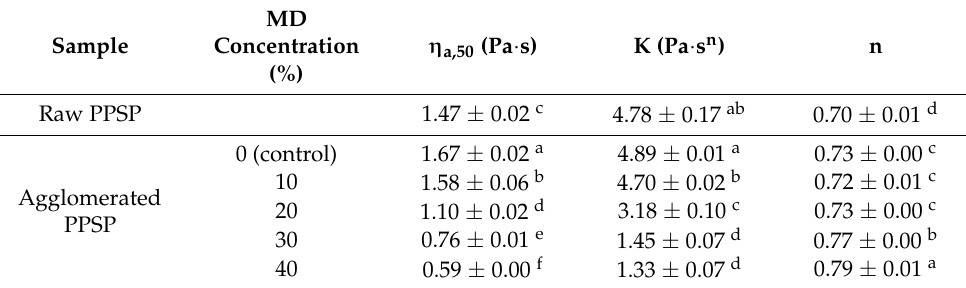
Figure 5. Plots of shear stress versus shear rate for raw and agglomerated PPSPs with different concentrations of MD binder: ( ) raw PPSP, ( (cid:3) ) PPSP—0%, ( (cid:52) ) PPSP—10%, ( (cid:35) Table 4. Values of power law model parameters ( η a,50 , K, and n) of raw and agglomerated PPSPs with different concentrations of MD